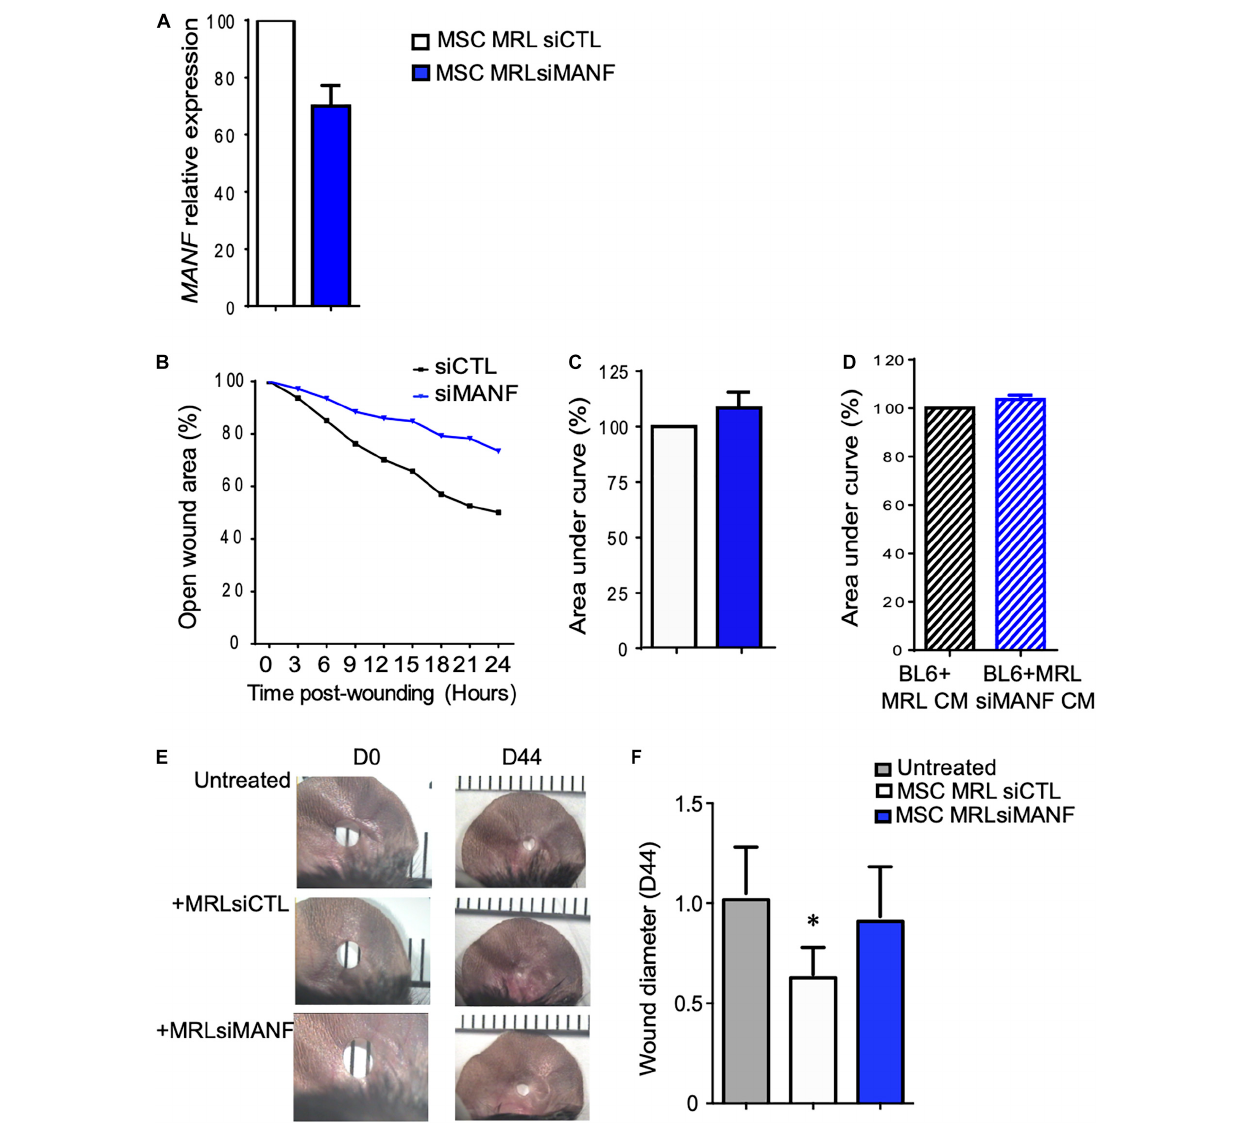
FIGURE 5 | The high migration and regenerative potential of MRL MSC depend on MANF. (A) MANF mRNA expression level in MRL MSC transfected either with a control siRNA (siRNA CTL) or a siRNA against PYCR1 (siMANF) 48 h post-transfection (mean ± SEM, from one representative experiment). (B) The migration potential of MRL MSC transfected with siCTL or siMANF were analyzed in a scratch wound assay by evaluating the area of the wound at 0, 3, 6, 9, 12, 15, 18, 21, and 24 h after wounding (mean ± SEM, from one representative experiment). (C) The area under curve (AUC) was calculated from the curve of open wound area percentage over the healing period (0–24 h). (D) The scratch wound was performed on BL6 MSC monolayer cultured alone or with a conditioned-medium obtained from a 24 h culture of subconfluent MRL MSC silenced for MANF (MRL siMANF CM) (mean ± SEM, n = 3.). (E) Pictures of the ear holes at day 0 and day 44 after wounding. The punch-holes in the ears of MRL mice were either untreated (untreated) or treated with MSC. MRL MSC transfected either with siCTL (MRLsiCTL) or siMANF (MRLsiMANF) were injected at the wound edges. (F) Quantification of the ear punch hole closure at day 44 using the image J program to define the ear punch area. Results represent the mean ± SEM. N mice = 10 per condition, Mann–Whitney test, two-tailed, when not indicated untreated versus MRL MSC siCTL , ∗ p ≤